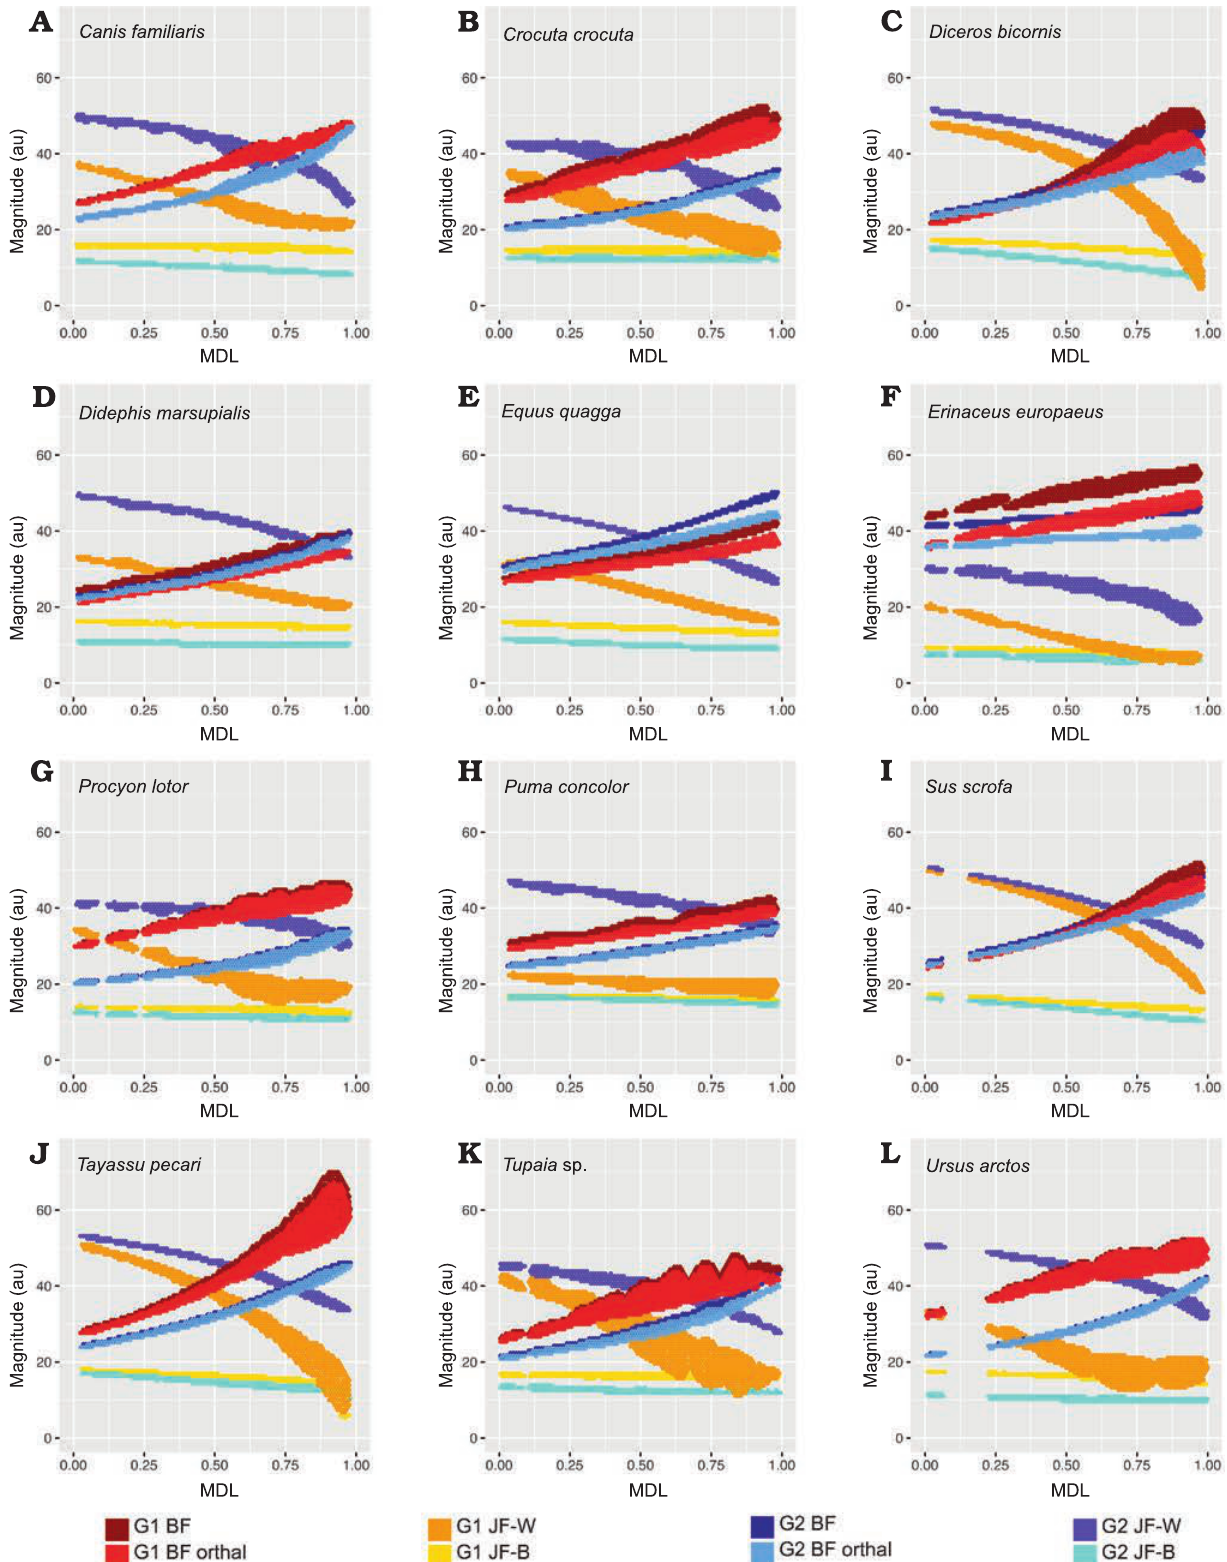
Fig. 8. 2D histograms showing distribution of estimated force magnitudes for Group 1 (G1) and Group 2 (G2) muscle recruitment scenarios (on ordinate), as a function of mesiodistal location (MDL; on abscissa). A . Canis familiaris . B . Crocuta crocuta . C . Diceros bicornis . D . Didephis marsupialis . E . Equus quagga . F . Erinaceus europaeus . G . Procyon lotor . H . Puma concolor . I . Sus scrofa . J . Tayassu pecari . K . Tupaia sp. L . Ursus arctos . Abbreviations: BF, bite force; JF-W/B, working-/balancing-side joint